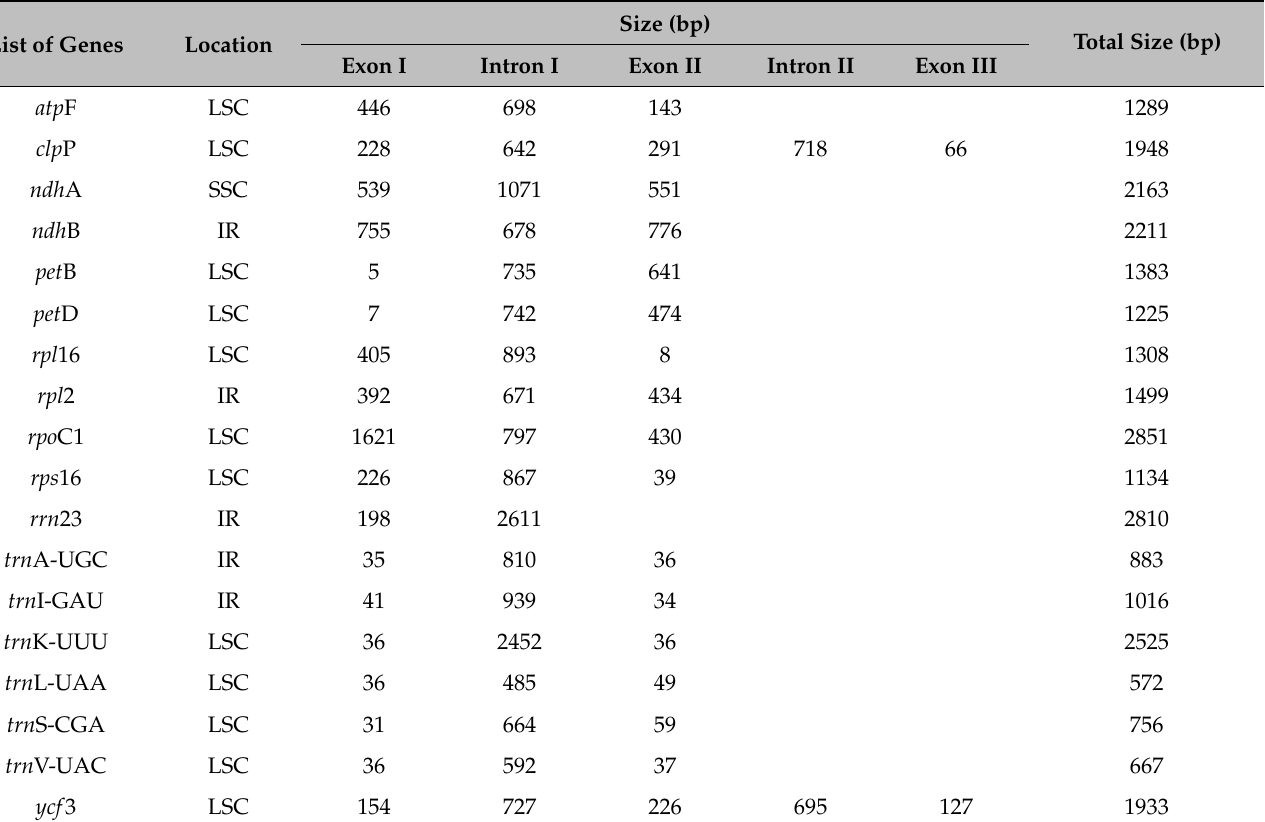
Table 3. Eighteen genes with introns in the five Barleria chloroplast genomes and length of the exons and